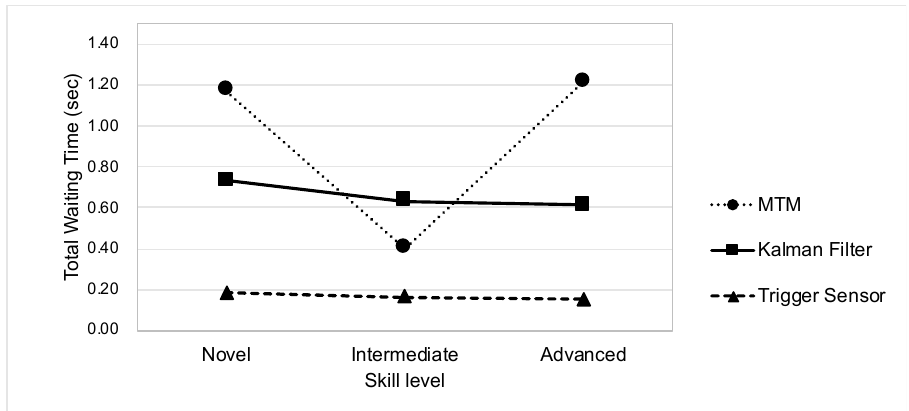
Figure 8. Average total waiting time for the three skill levels and handover prediction models.